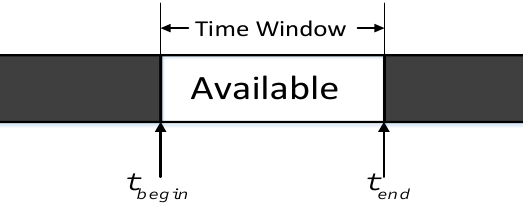
Figure 4. Time window of the reconnaissance task.